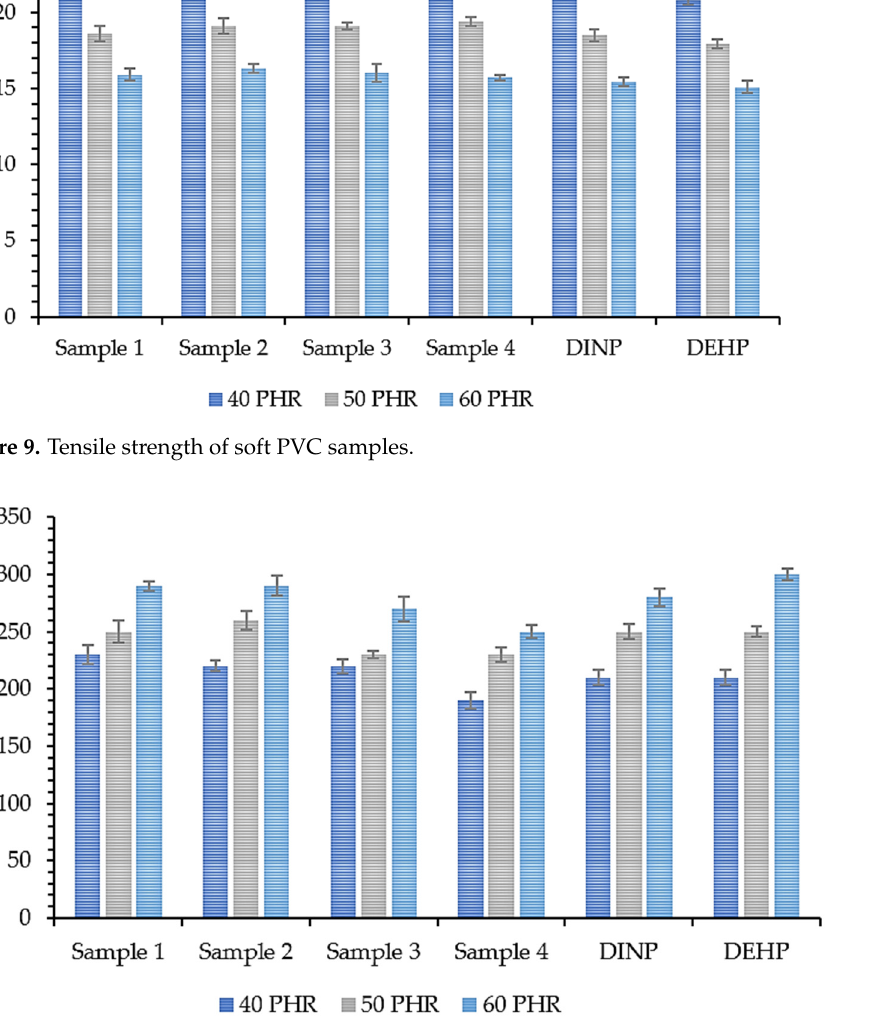
Figure 10. Elongation at break of soft PVC